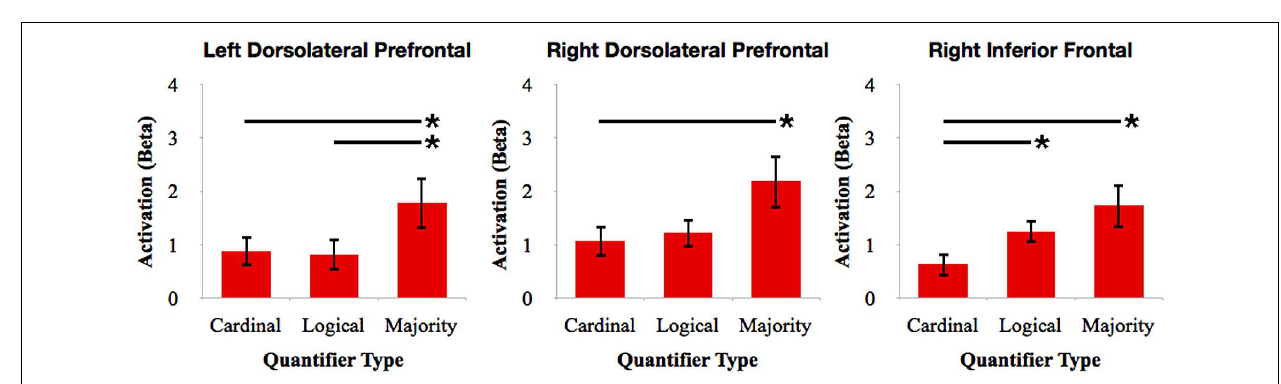
FIGURE 4 | Relative activation of ROIs in frontal cortex for cardinal, logical, and majority quantifiers. Bars with asterisks (*) represent p < 0.05